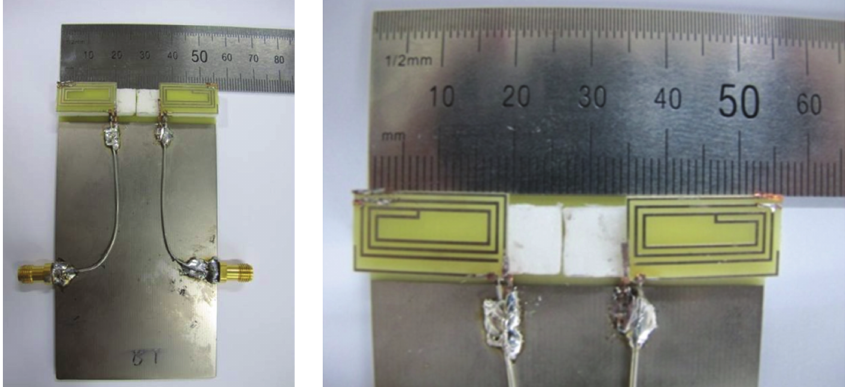
Figure 10: Photographs of the fabricated